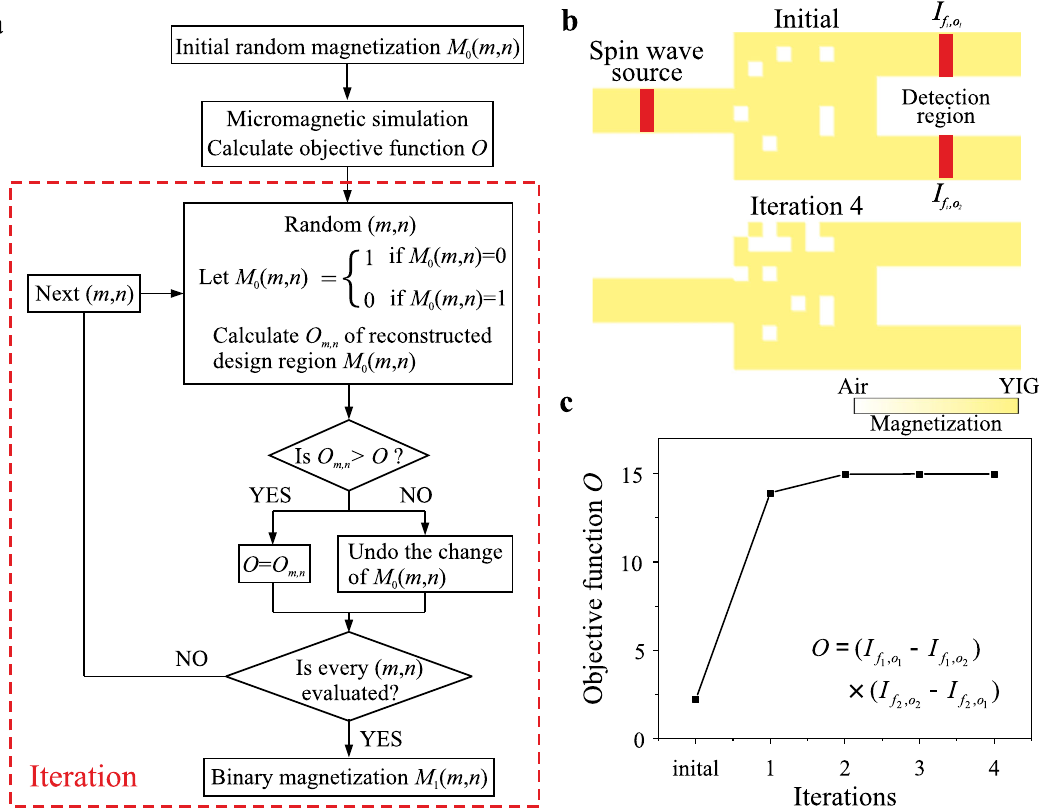
Fig. 2 The optimization procedure of direct binary search algorithm. a Flow chart of the Direct Binary Search (DBS) algorithm for one iteration. Every iteration includes 100 simulations in our examples. b The random initial magnetization distribution and the magnetization distribution after four iterations. The red regions show the excitation and detection regions. c Evolution of objective function O as a function of the iteration number. The DBS algorithm has shown a particularly high ef fi ciency in the case of spin waves and all the designs reported further required below fi ve iterations